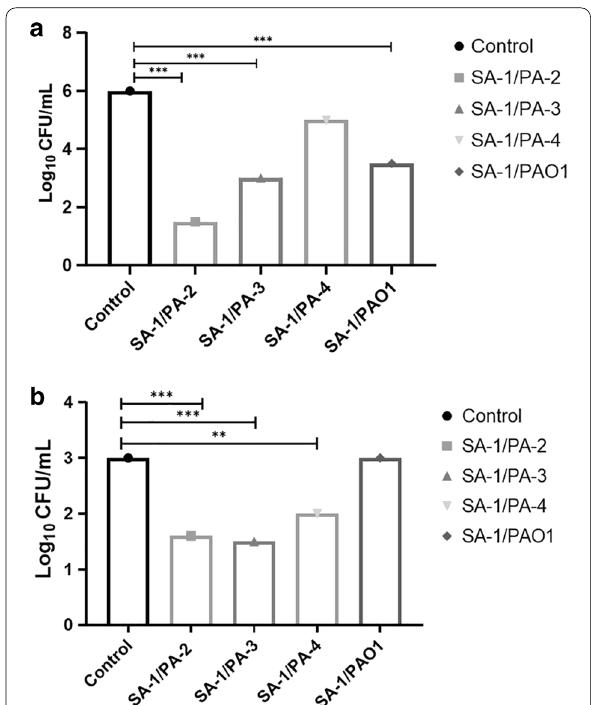
Fig. 1 The planktonic ( a ) and biofilm ( b ) states of the co-culture of P. aeruginosa—S. aureus on the A549 cell line. The viability of P. aeruginosa was measured as log 10 (CFU/well) in the co-culture with S. aureus . The error bars indicate the standard errors of the means in a representative triplicate time. ’. *: p < 0.05, **: p < 0.001, ***: p <